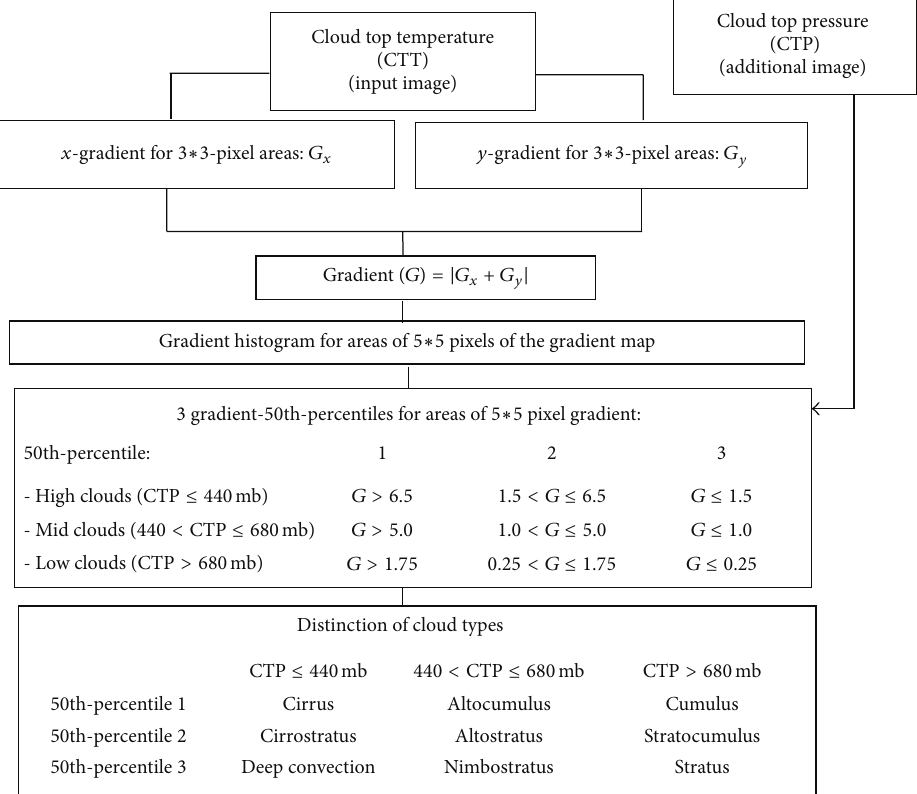
Figure 3: Flow chart of the thermal image segmentation for cloud type morphology differentiation based on the histogram CTT gradient